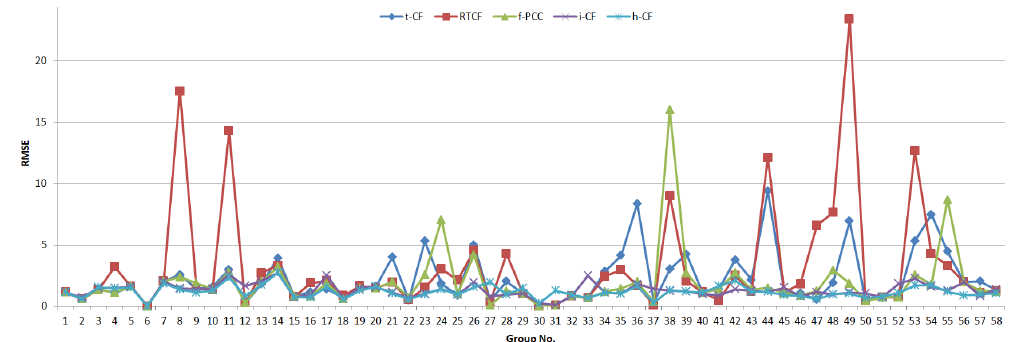
Figure 5. RMSE (Rooted Mean Squared Error) comparisons among the five methods based on the same 58 group target